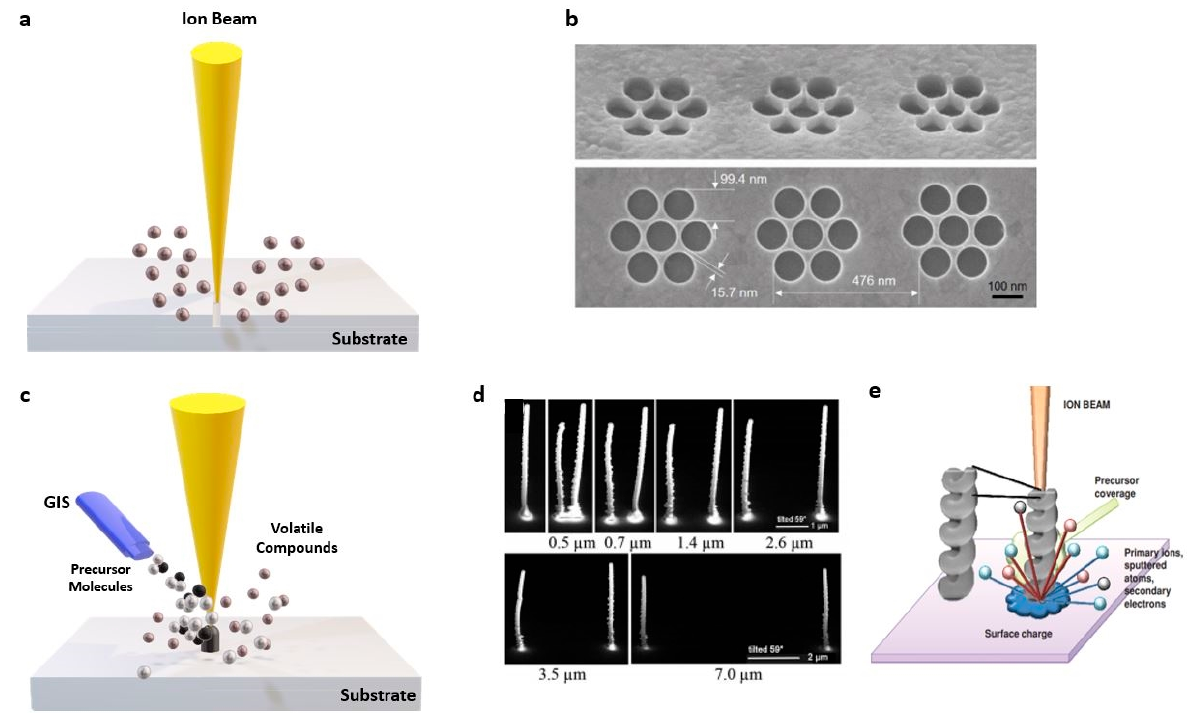
Figure 1. ( a ) Scheme of the focused ion beam milling. The ions coming from the beam collide on the surface, digging the targeted area. ( b ) Helium Ion Microscope (HIM) images of 54 ◦ tilted view (top) and top view (bottom) of plasmonic nanohole arrays realized with He + milling on Au/SiO 2 substrate. The array consists of seven close-packed holes with 100nm diameter and separated by 15nm of sharp edges without milled material redeposition. Reproduced with permission from [48]. ( c ) Scheme of the focused ion beam induced deposition (FIBID) procedure: The ions coming from the beam decompose the precursor molecules coming from the gas injection systems leaving a deposit on the substrate. The residual organic compounds are removed from the vacuum system. ( d ) Scanning electron microscope (SEM) images representing the proximity effect for six pillar pairs with different separations gaps from 0.5 up to 7.0 µ m. The metal-organic precursor gas (CH 3 ) 3 Pt(CpCH 3 ) is used as the gas source. The pillars have been grown on a Si 3 N 4 /Si wafer. Reproduced with permission from [58]. ( e ) Schematic image representing all the effects happening during the FIBID process in the fabrication of a multiple loops nanohelix: The interaction with the sample led to scattered particles, charge effects, and proximity effects. Reproduced with permission from [54].